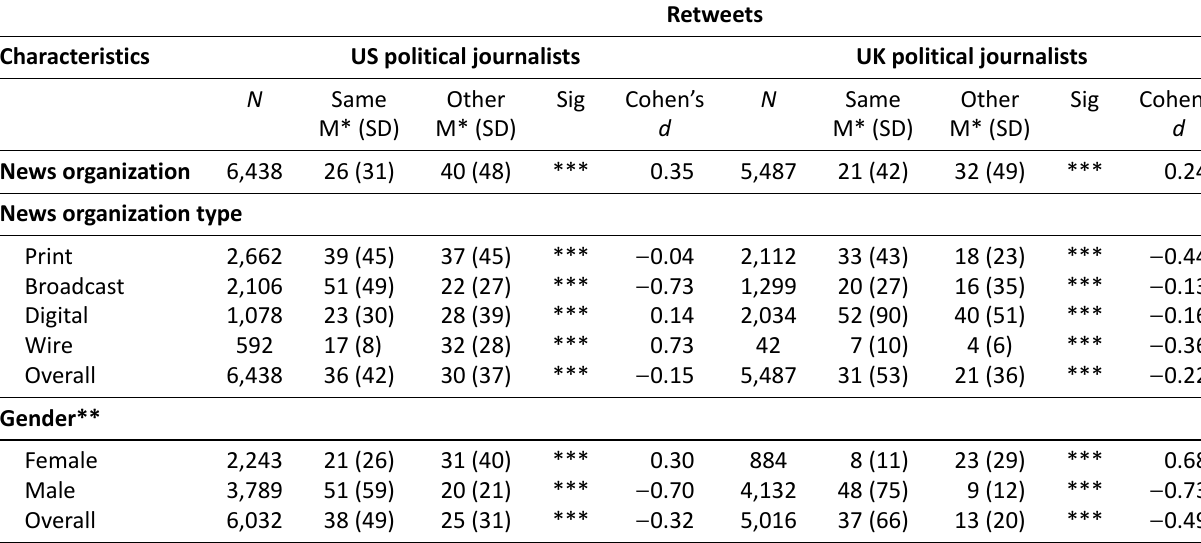
Table 2. Shared characteristics in retweets.